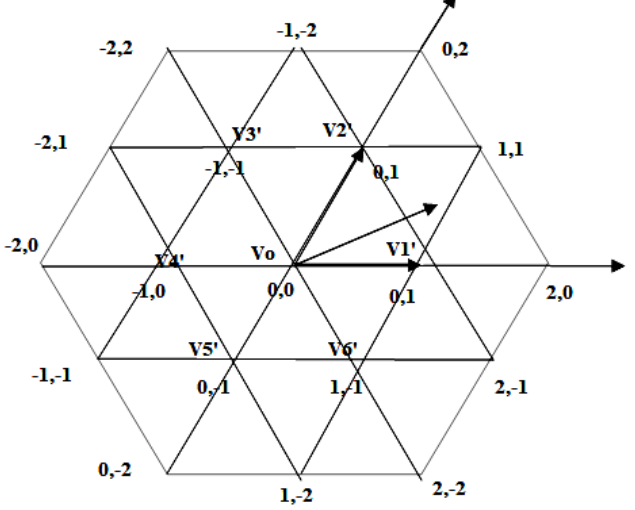
Figure 45. Sixty degree Space Vector Pulse Width Modulation (SVPWM) technique.